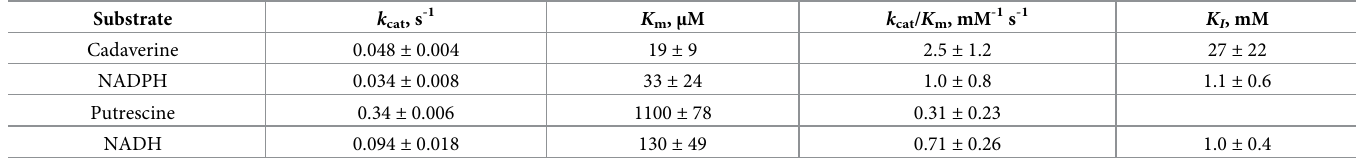
Initial rates measured with varied concentrations of cadaverine or putrescine (or 10 mM) in the presence of Ss DesB, 50 μ M FAD, and 0.7 mM NAD(P)H (or varied concentrations). All measurements were made in